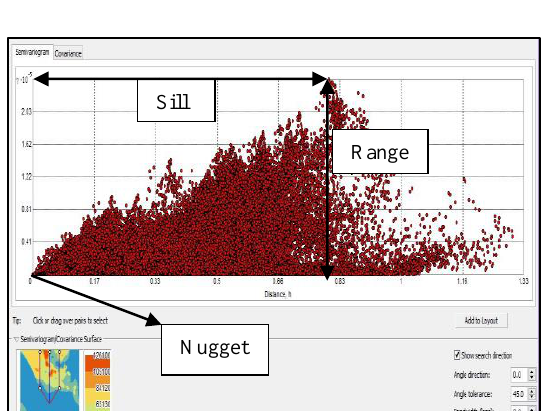
Figure 6: Histogram